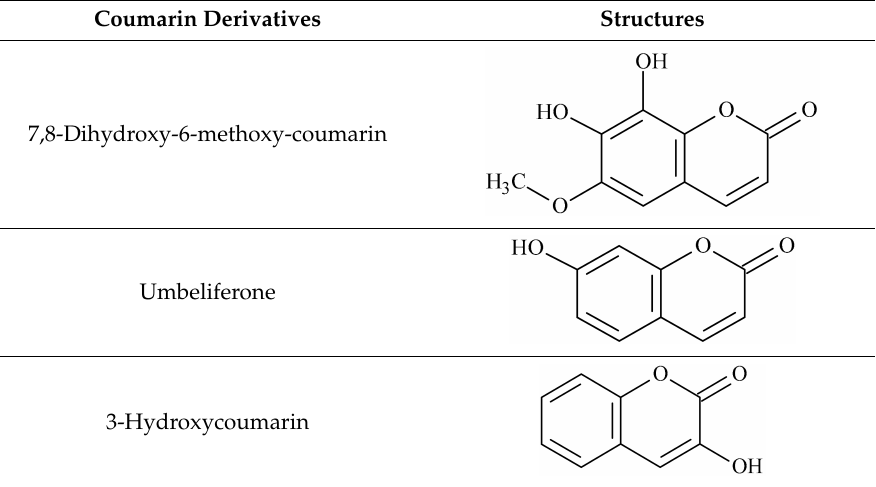
Table 3. Coumarin derivatives identified in Artemisia